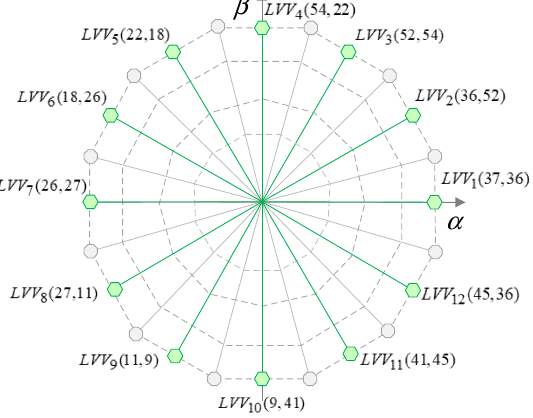
Figure 3. Available large voltage vectors in 𝛼 - 𝛽